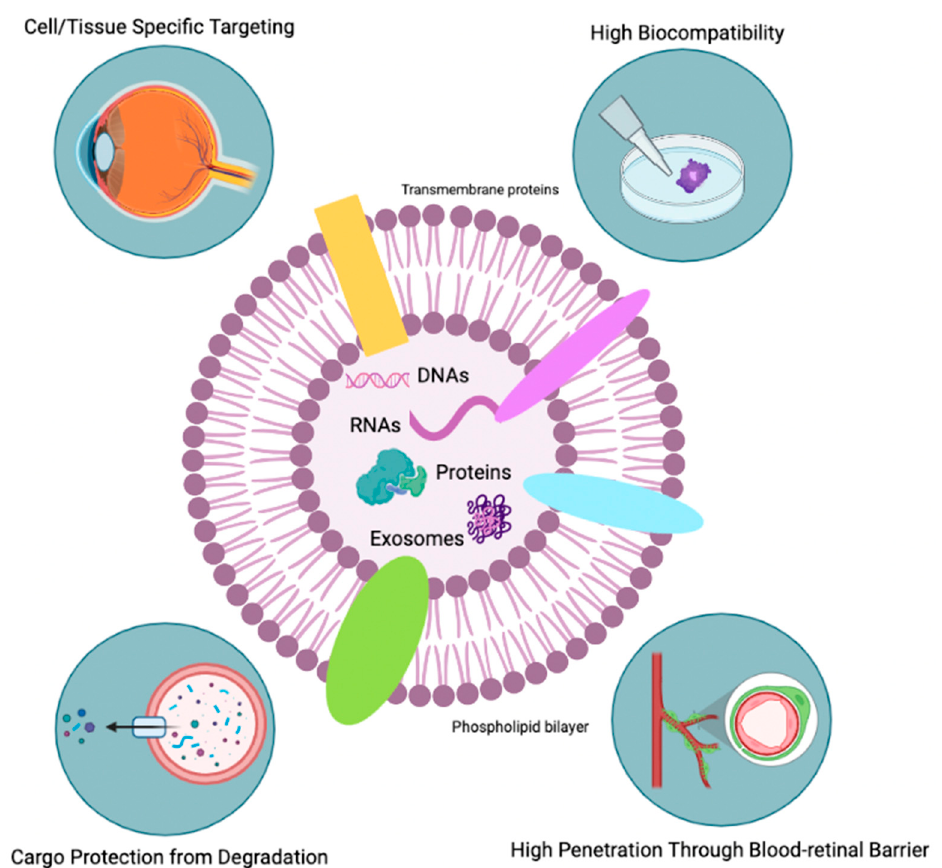
Figure 4. Favorable characteristics of exosomes. This Figure illustrates the favorable characteristics of exosome therapy, including its ability to target specific cells and tissues, high biocompatibility, resistance to degradation, and capacity to penetrate barriers such as the blood-retinal barrier. Adapted by BioRender.com (2023). Retrieved from https://app.biorender.com/biorender-templates (accessed on 20 January 2023) .